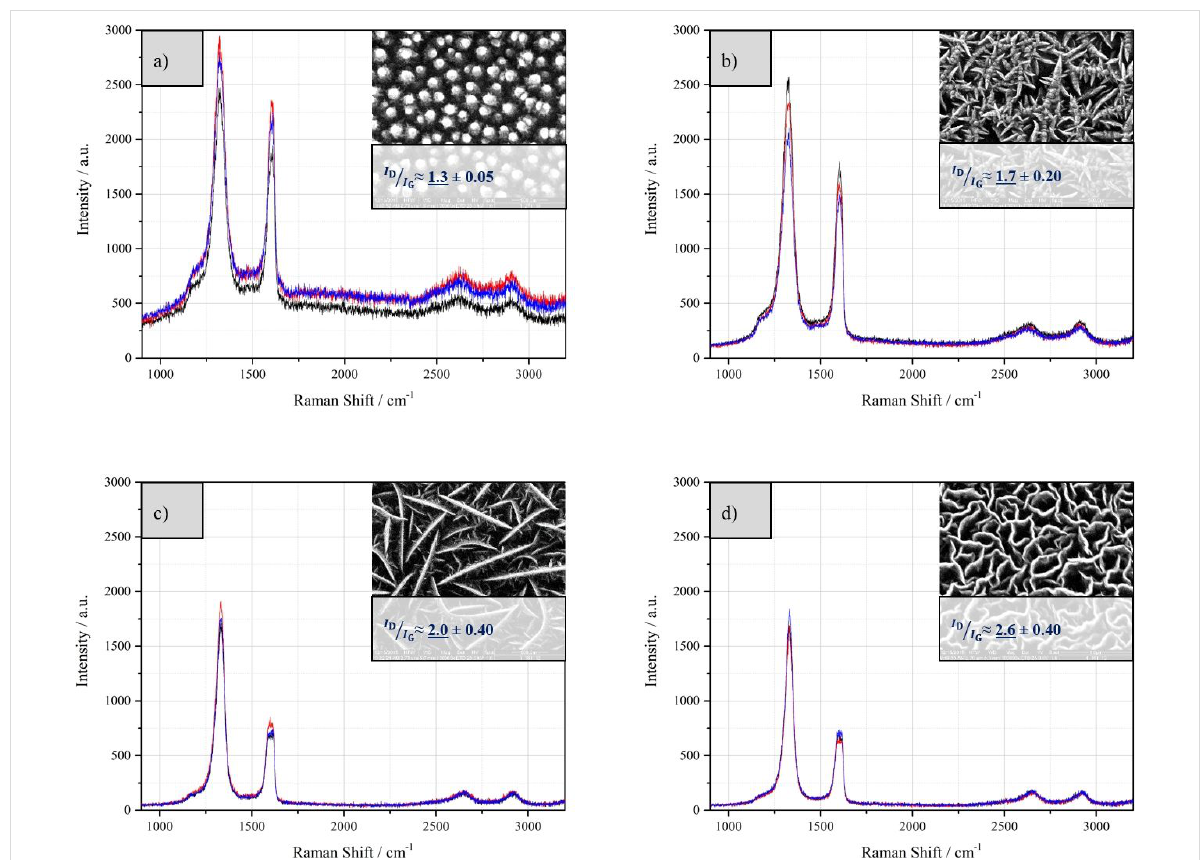
Figure 7: Typical Raman spectra and the I D / I G ratios for a) nanorods, b) thorny CNWs, c) straight CNWs and d) curled CNWs. All structures were synthesized on stainless steel.